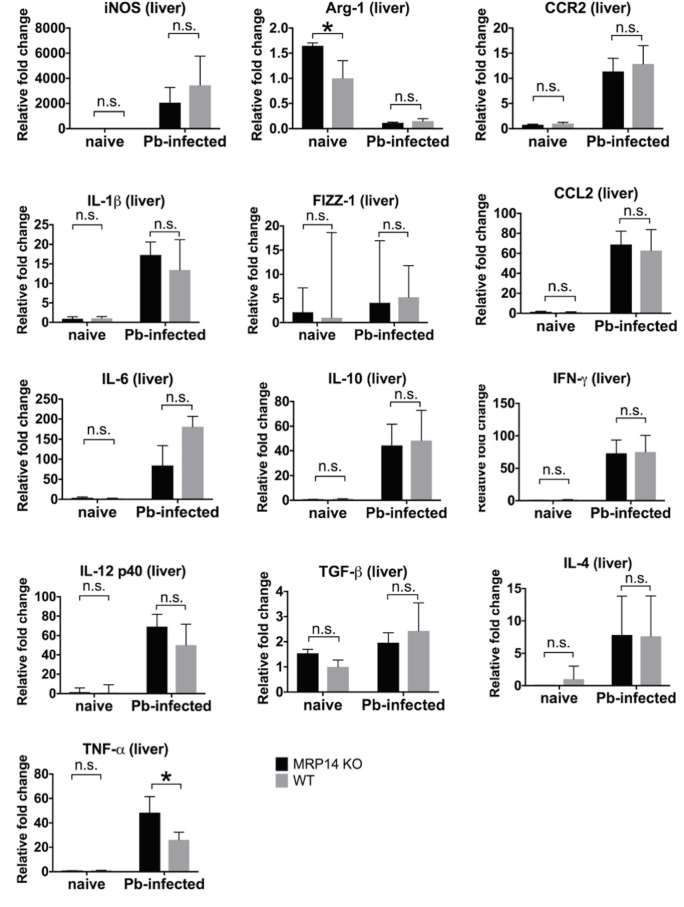
Enhanced pro-inflammatory molecules independent of MRP14 in the liver during rodent malaria.mRNA expression of iNOS, IL-1β, IL-6, IL-12 p40, TNF-α, Arg-1, FIZZ-1, IL-10, TGF-β, NOX2, CCR2, CCL2, IFN-γ and IL-4 in the liver of MRP14-KO mice and WT mice after Pb-infection (n = 5). Graphs show mean and SD of each group. Data are representative of two independent experiments. *P < 0.05; n.s., not significant.